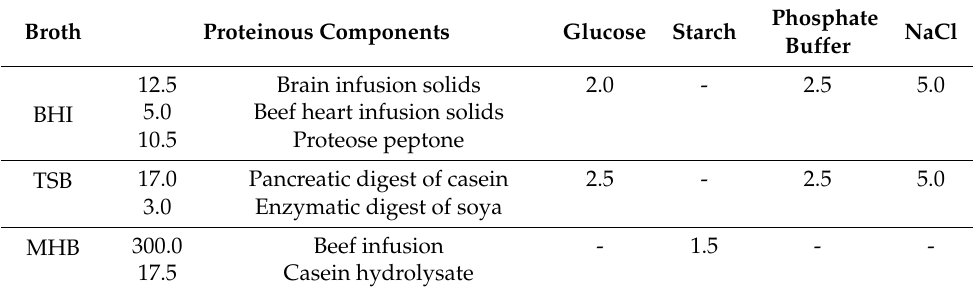
Table 2. Comparison of the liquid media composition [g/L].